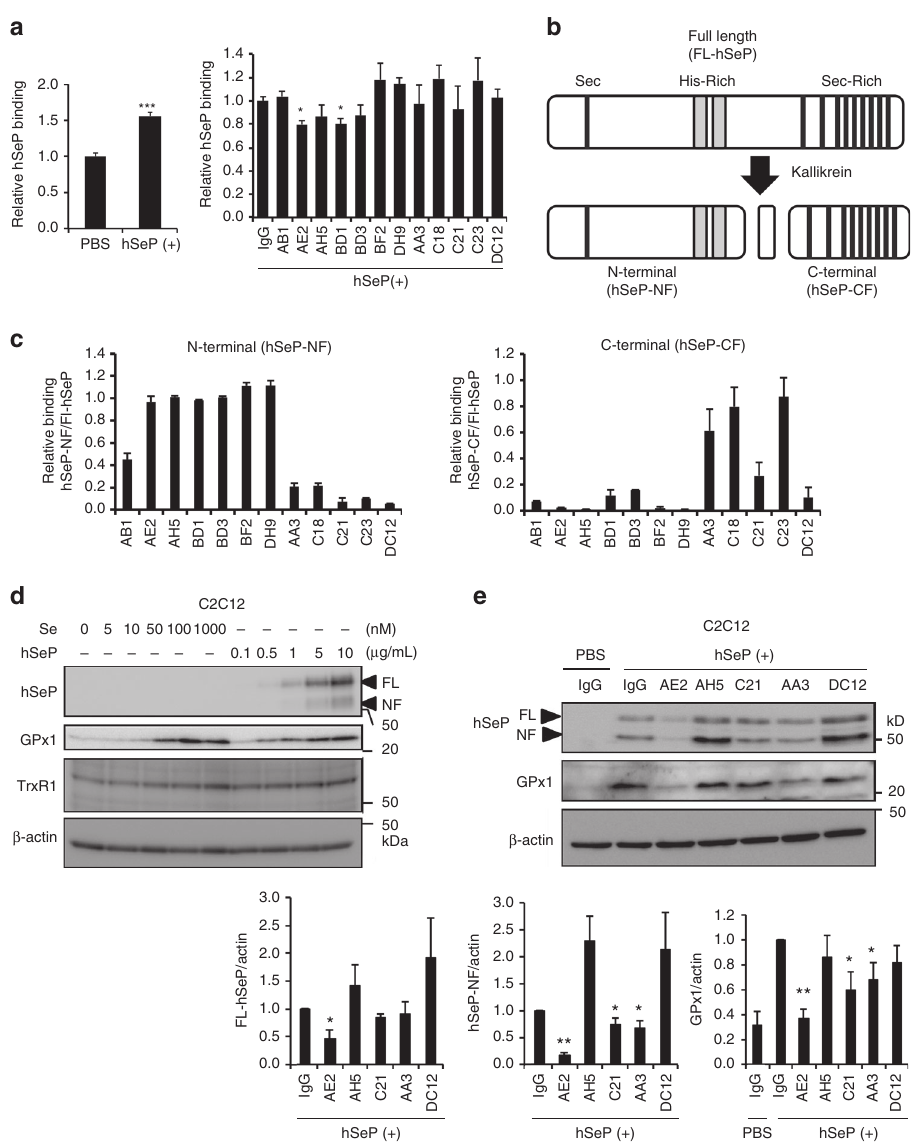
Fig. 1 Identi fi cation of antibodies inhibiting the binding and selenium supply of SeP. a Inhibitory effects of monoclonal antibodies on the interaction between undifferentiated C2C12 cells and human SeP. C2C12 cells were incubated with puri fi ed human SeP (hSeP) protein (0.5 µ g/mL) in the absence (left panel) or the presence (right panel) of each mAb (10 µ g/mL) at 4 °C, and then SeP binding was analysed ( n = 3, means ± s.d.). *** P < 0.001, Student's t -test (left panel), * P < 0.05, vs. control IgG, Tukey-ANOVA (right panel). b Schematic representation of limited proteolysis of human SeP by plasma kallikrein. The sequential limited proteolysis of full-length-hSeP (FL-hSeP) by plasma kallikrein (R235-Q236 and R242-D243) resulted in the generation of N-terminal (hSeP-NF) and C-terminal fragments (hSeP-CF). c Immunoreactivity of each mAb against hSeP-NF and hSeP-CF was determined by direct ELISA ( n = 3, means ± s.d.). Relative binding, hSeP-NF immunoreactivity/FL-hSeP immunoreactivity and hSeP-CF immunoreactivity/FL-hSeP immunoreactivity, is shown. d Differentiated C2C12 myocytes were treated with each concentration of sodium selenite (Se) and hSeP for 24 h, as described in the Methods, and then whole-cell lysates were analysed by western blotting with anti-hSeP Ab BD1, anti-GPx1 Ab and anti-TrxR1 Ab KB12. e Effects of monoclonal antibodies for Se-supply activity of human SeP in C2C12 myocytes. C2C12 myocytes were treated with hSeP (0.5 µ g/mL) in the presence of each mAb (10 µ g/mL) for 24 h. Human SeP and GPx1 levels in whole-cell lysates were determined by western blotting ( n = 3, means ± s.d.). The band intensity of hSeP was only evaluated in hSeP-treated cells. ** P < 0.01, * P < 0.05, vs. control IgG of hSeP-treated cells,